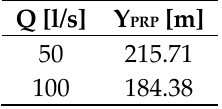
Table 4. Pressure heads at the Pietrasanta reservoir in the case of partial pipe replacement (PRP).